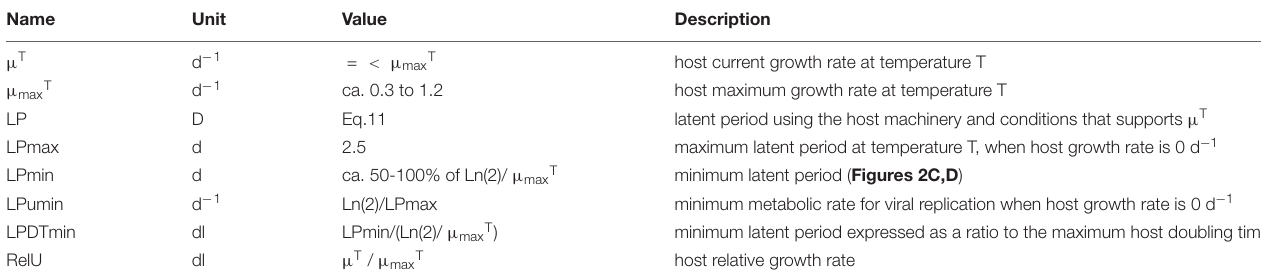
TABLE 2 | Parameters describing the latent